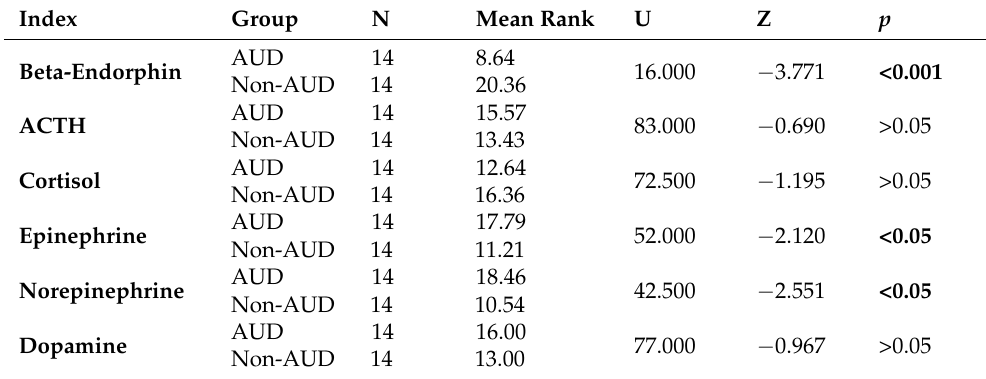
Table 4. Parameters of HPA-axis of AUD versus non-AUD